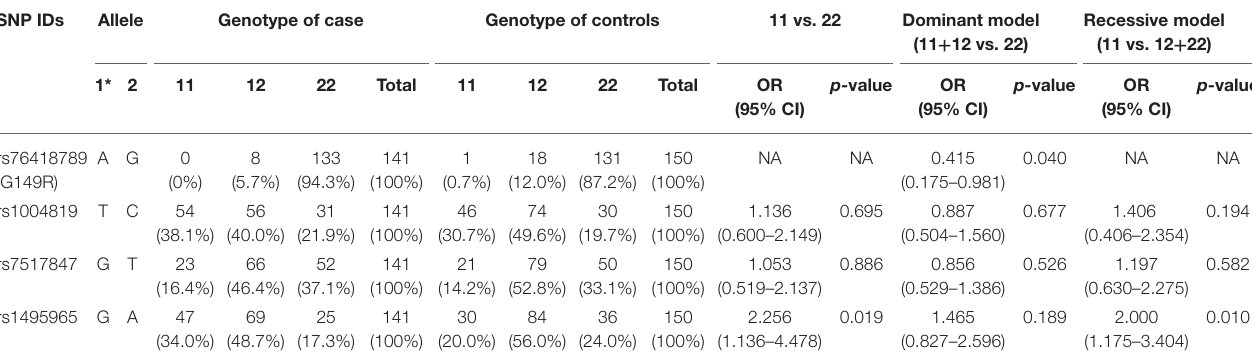
TABLE 4 | Comparison of genotype distribution between patients with Crohn’s disease and controls.